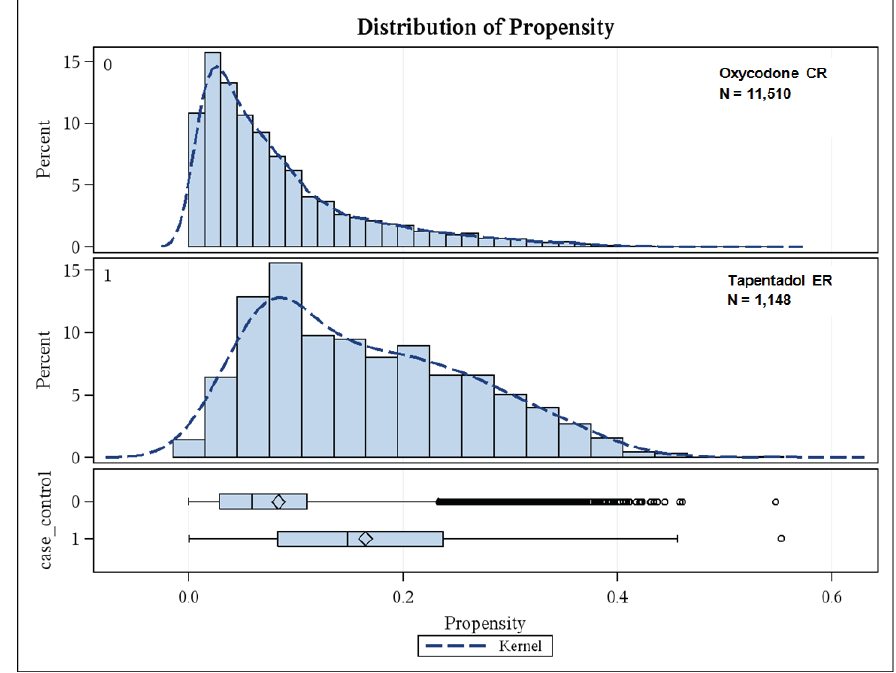
Figure 1. Propensity Score Distributions (A) Pre-Match Cohorts. One oxycodone CR patient with a non-matchable geographic area was